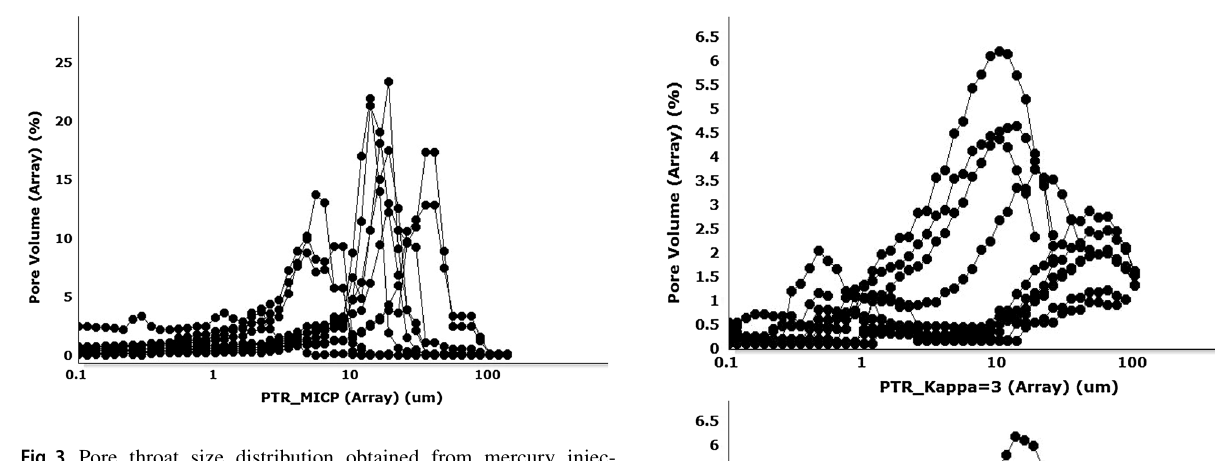
Fig. 3 Pore throat size distribution obtained from mercury injec- tion capillary pressure dataset indicating macropores greater than 100 microns